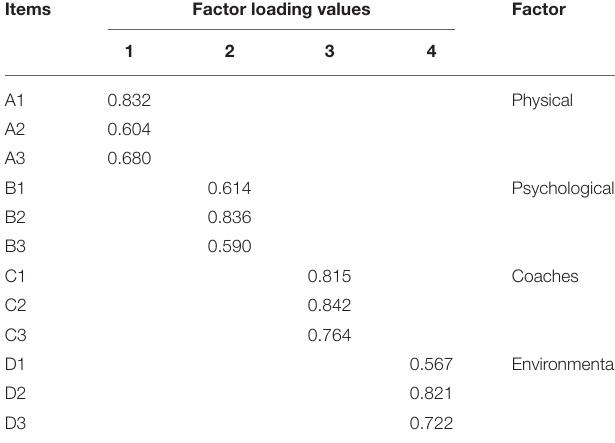
TABLE 7 | Rotating component